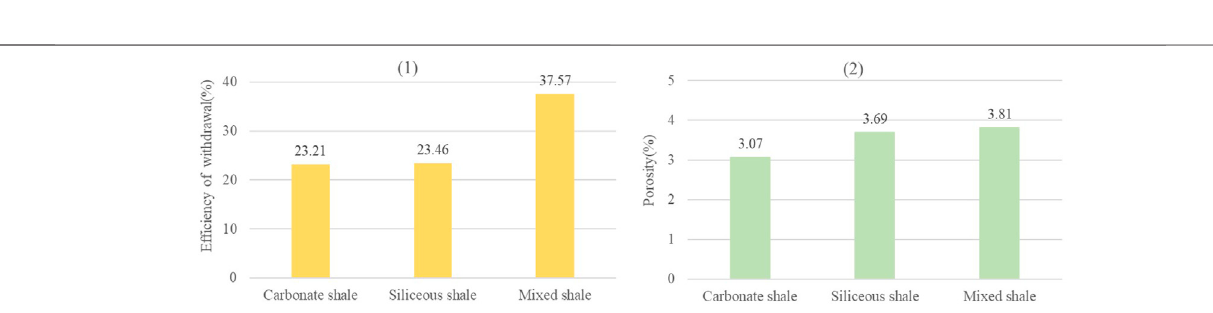
FIGURE 7 | Comparison of the ef fi ciency of mercury withdrawal and porosity in different rock structures.